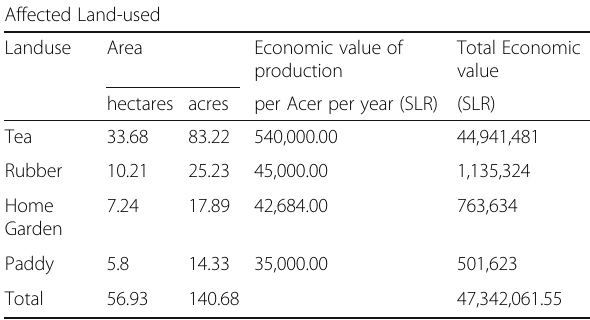
Table 2 Estimate the economic value of the productions from selected land-use categories available in the landslide area Affected